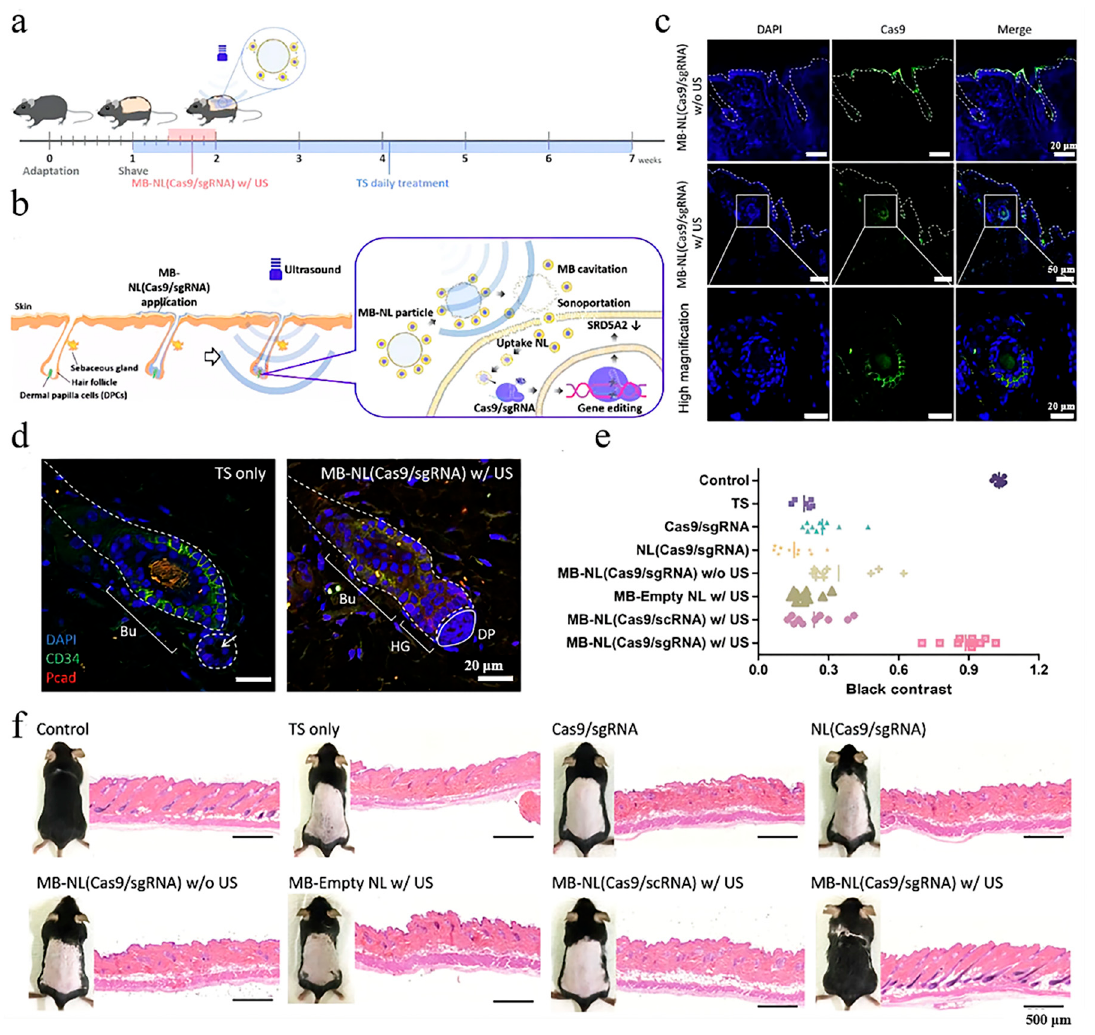
Figure 3. Ultrasound-activated particles as a CRISPR/Cas9 delivery system for androgenic alopecia therapy. ( a ) Schematic diagram of the in vivo experiment. ( b ) Schematic diagram of the US flash exposure (MI = 0.61) and enhancement of NL. ( c ) Confocal laser scanning microscopy (CLSM) images of the mouse skin harvested at 2 h after treatment with MB-NL(Cas9/sgRNA) particles. ( d ) CLSM images of the mouse skin and HFs stained with anti-CD34 (green) and anti-P-cadherin (red) antibodies after TS- or US-activated ML-NL(Cas9/sgRNA) treatment. ( e ) Comparison of black hair contrast intensity. ( f ) H&E staining of harvested mouse skin after 7 weeks of treatment [39]. Copyright 2020